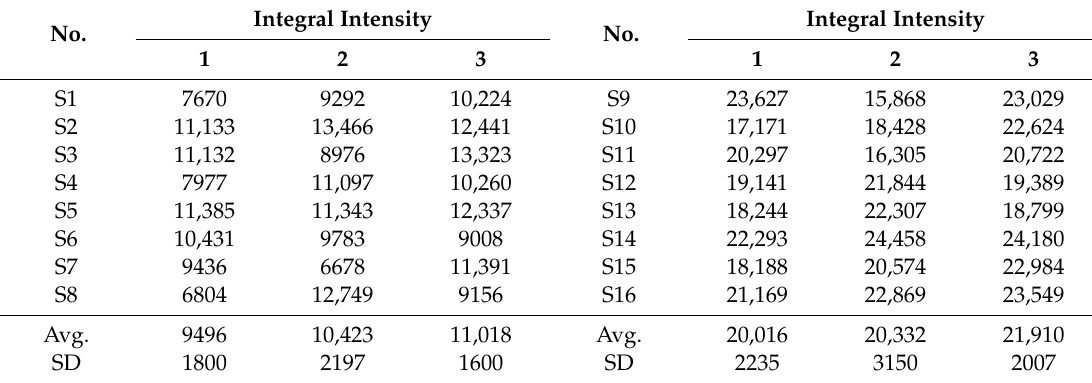
Table 3. Integral intensities of asbestos peaks for standard sepiolite samples with di ff erent ACM concentrations (1% and